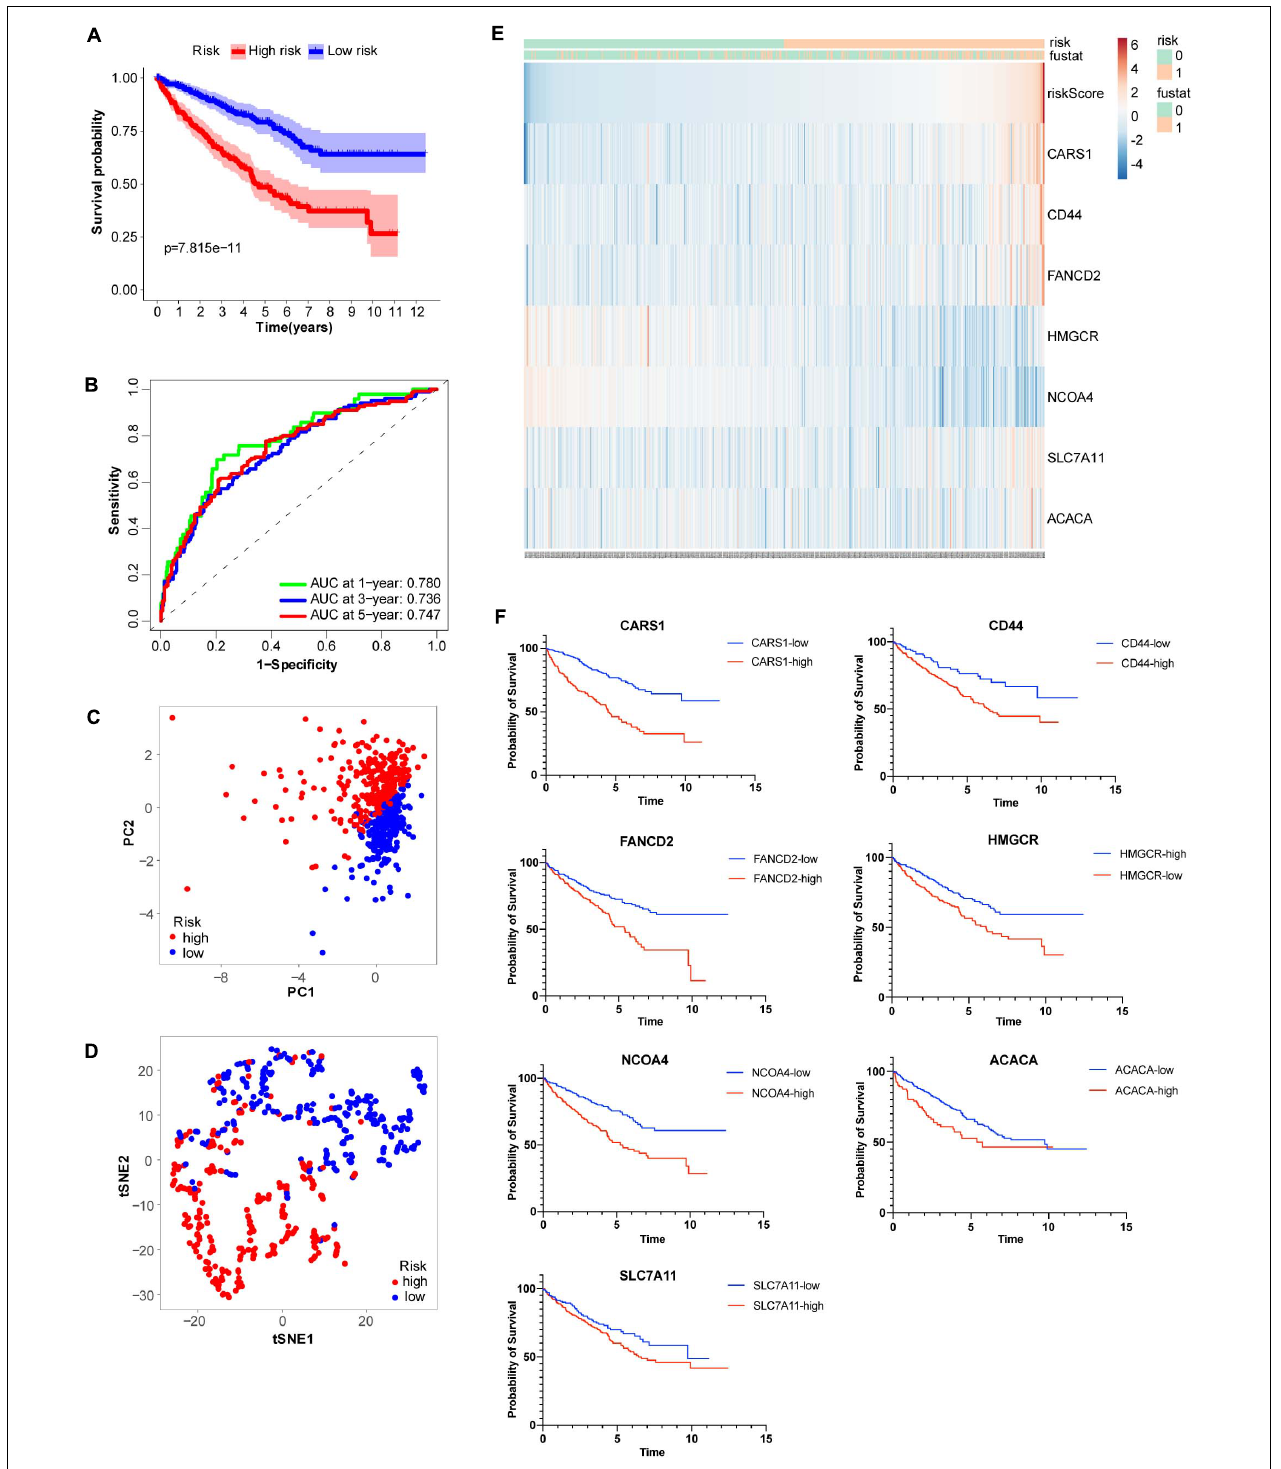
FIGURE 3 | Analysis of ferroptosis-related genes (FRGs) as an independent prognostic factor. (A) Kaplan–Meier survival curves show overall P values of survival and 95% CI for high − and low − risk patients with clear cell renal cell carcinoma (ccRCC) based on the novel model. (B) One − , 3 − , and 5-year receiver operating characteristic (ROC) curves and area under the curve (AUC) = 0.780, 0.736, and 0.747, respectively. (C) Principal component analysis of FRGs showed two patient clusters. (D) t-Distributed stochastic neighbor embedding plots for non-linear dimension divided ccRCC into two groups by the new risk score model. (E) Heatmap showing differentially expressed ferroptosis-related genes between high − and low − risk. (F) Kaplan-Meier survival curves of the seven genes in ccRCC.